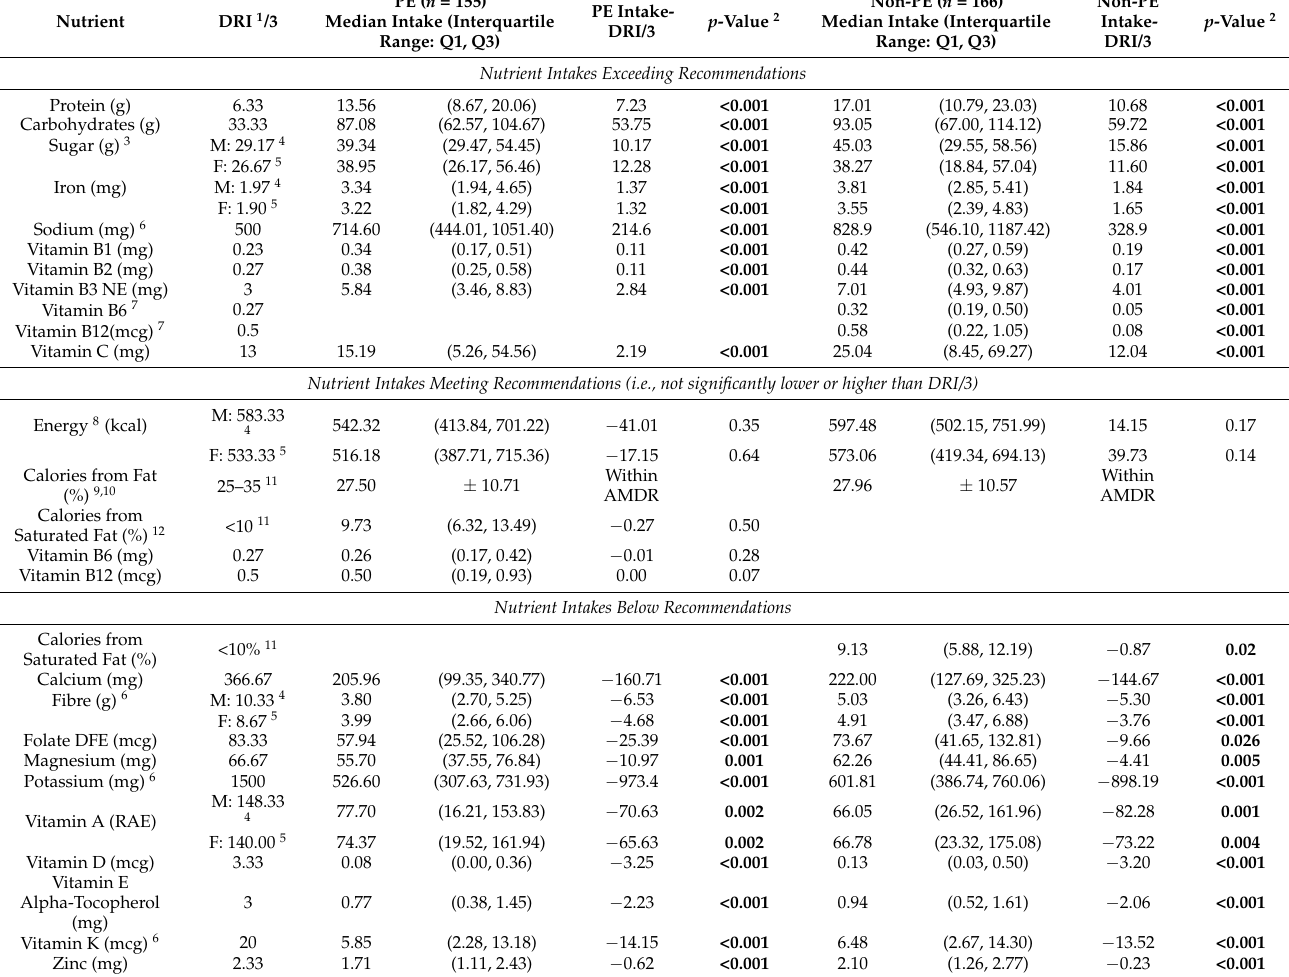
Table 3. Nutrient consumption from home-packed school lunches by picky eating status and recommended